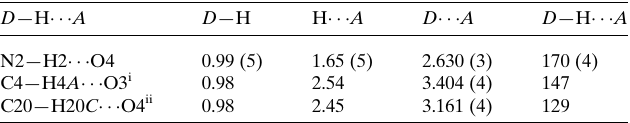
Table 1 Hydrogen-bond geometry (A˚ , (cid:5) ).